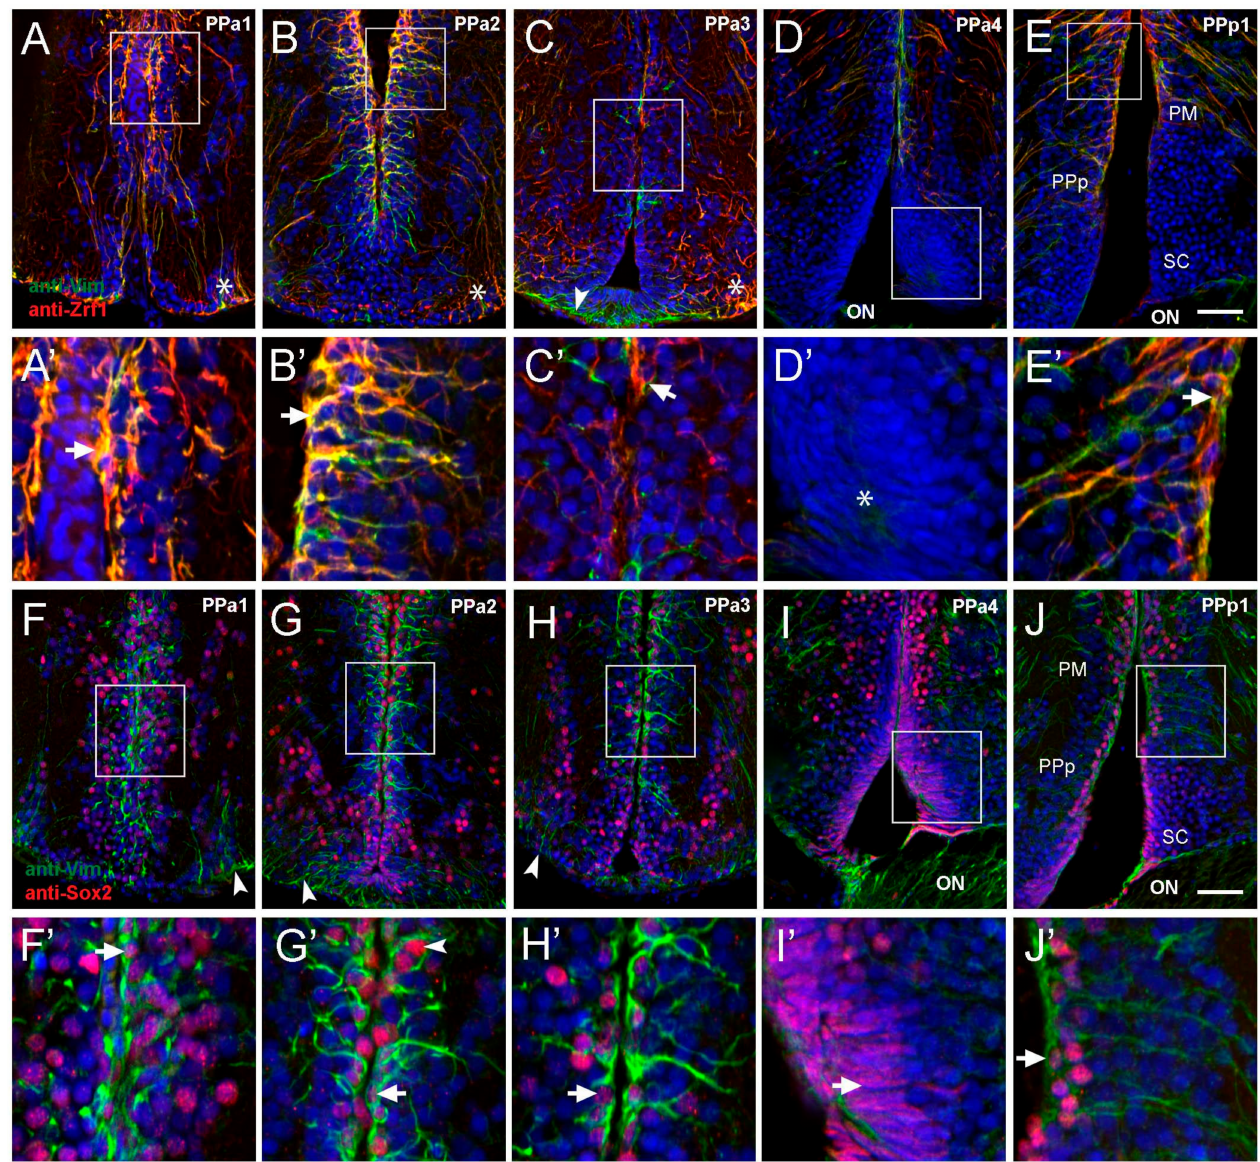
Figure 2. Cells lining the diencephalic ventricle (DiV) express neural progenitor markers. ( A – J ) Expression of Vim, Zrf1, and Sox2 in transverse paraffin-sections of 10 µ m of the POA. ( A – E ) Cells immuno-positive for anti-Vim (red) and anti-Zrf1 (green). ( A , B ) Vim+/Zrf1+ positive cells are distributed dorsomedially in the wall of the third ventricle (boxed area), and signals are co-localized (( A’ , B’ ), arrows). ( C ) Fewer Vim+/Zrf1+ cells are observed in PPa3 (boxed area) with limited co-localization (( C’ ), arrow). (( A – C ), asterisks) Vim+/Zrf1+ cells are located in the ventrolateral region with long processes that extend towards the DiV (arrowheads). ( D ) Vim-/Zrf1- cells with fusiform nuclei are found in at ventral sur-face of POA (( D’ ), asterisk). ( E ) Vim+ and Zrf1+ label in dorsomedial region (boxed area), is co-localized (( E’ ), arrow). ( F – J ) Cells immune-positive for anti-Vim and anti-Sox2. ( F – H ) Vim+ cells also label with anti-Sox2 (red) (boxed area), and Sox2+ cells are observed in dorsal-ventral regions of the ventricle wall. ( F’ – H’ ) Higher magnification views of box areas in F-H: Vim+/Sox2+ co-localization in cells (arrows). ( I ) Cells with fusiform nuclei are Sox2+ and are located in the ventral wall (( I’ ), arrow). ( J ) Vim+ and Sox2+ boxed area, co-localize in ventricle wall (( J’ ), arrow). Diencephalic ventricle (DiV); magnocellular nucleus (PM); optic nerve (ON); anterior part of the parvocellular preoptic nucleus (PPa); posterior part parvocellular nucleus (PPp); suprachiasmatic nucleus (SC). All sections labeled with DAPI (blue). Scale bar: 30 µ